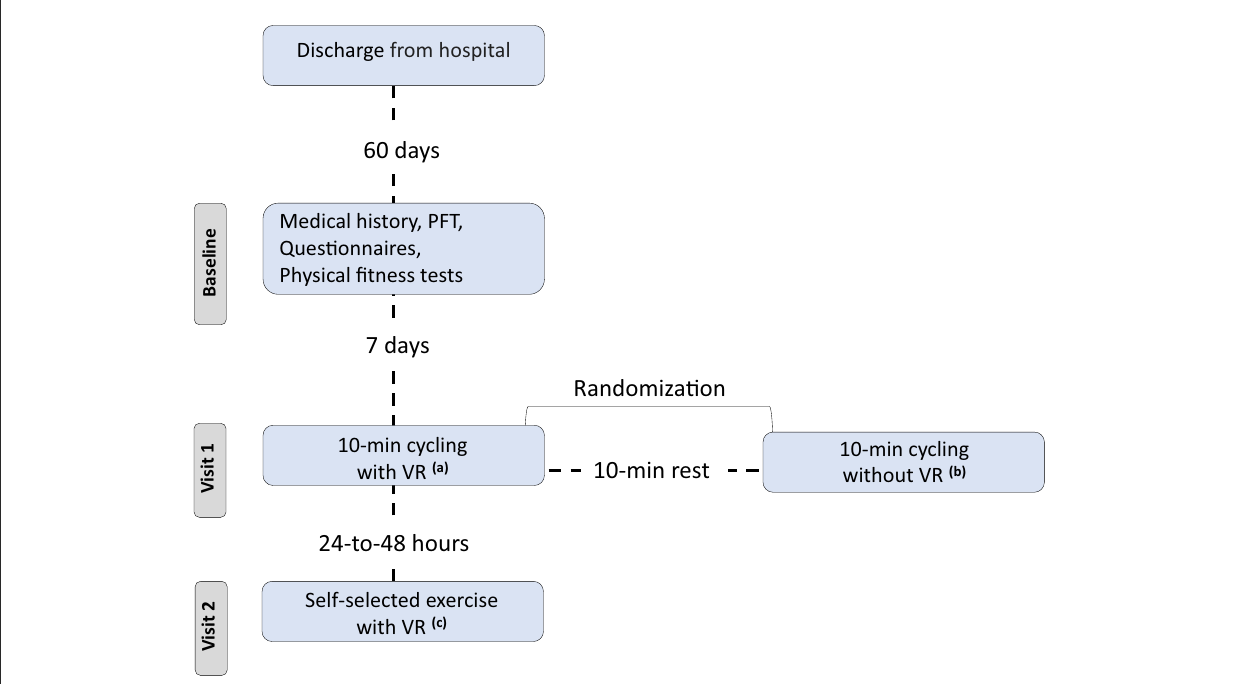
FIGURE1 Flow chart. PFT, pulmonary functional test; VR, virtual reality system. a Exercise using the VR system and 10-min duration, b Exercise without using the VR system and 10-min duration, c Exercise using the VR system, and each patient selected the duration of session.